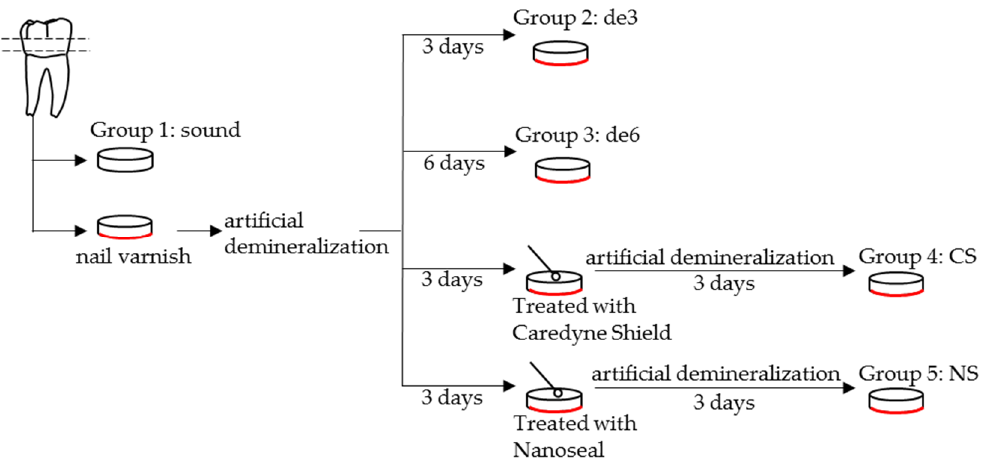
Figure 1. Schematic illustration of the dentin specimen preparation for swept-source optical coherence tomography (SS- OCT) and SEM analysis. The 25 dentin discs were divided into five groups of five samples each. An acetic acid solution with pH 5.0 was employed as the artificial demineralization solution, and the solution was replaced every day during the process.